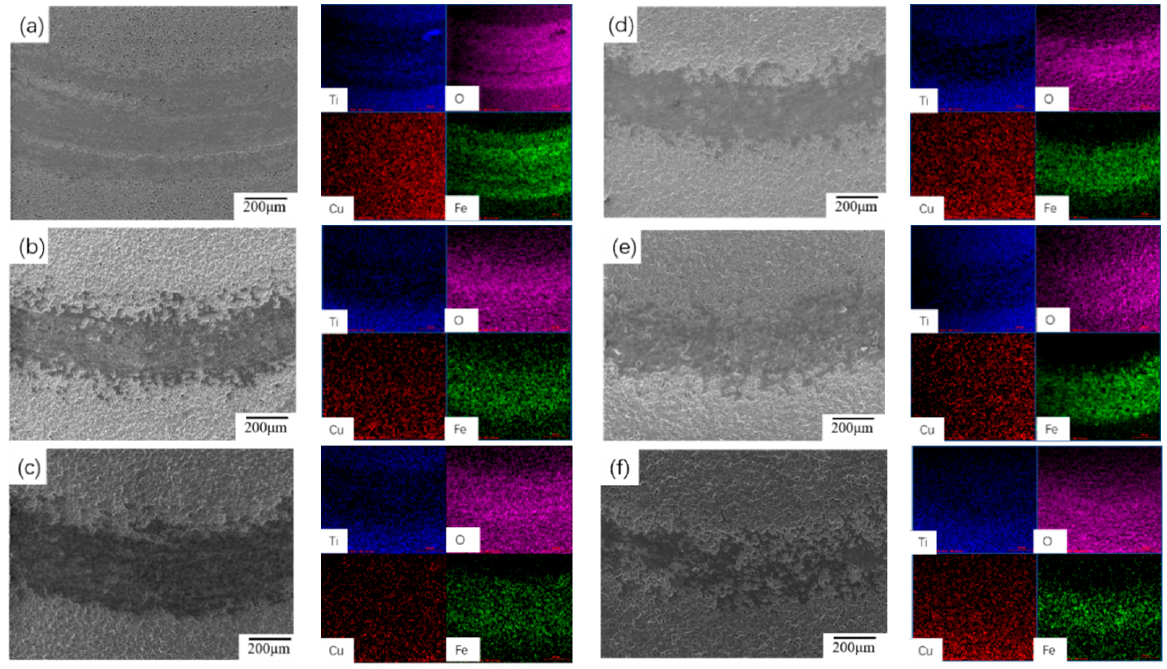
Figure 5. SEM images and EDS spectrums of MAO-treated TC4 with various concentrations of CuSO 4 doping: ( a ) 0, ( b ) 2, ( c ) 4, ( d ) 6, ( e ) 8, and ( f ) 10 g/L.